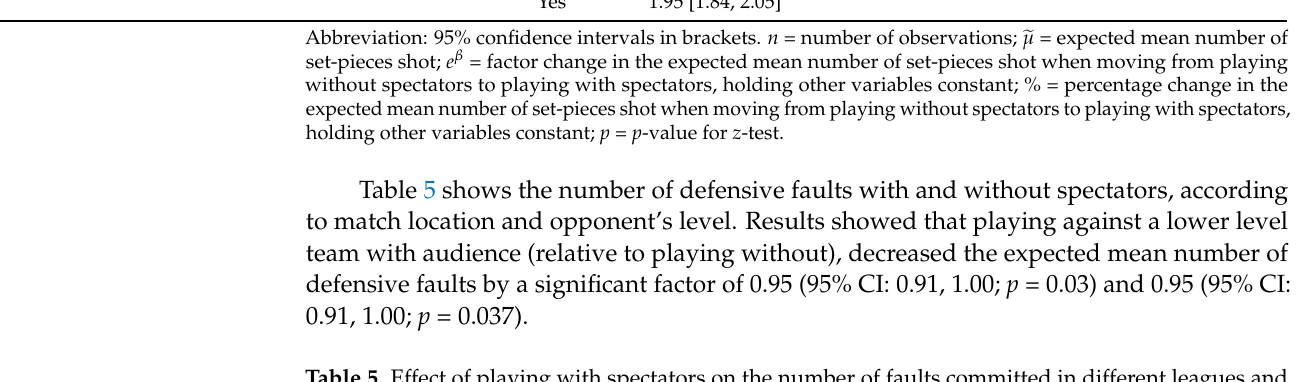
Table 5. Effect of playing with spectators on the number of faults committed in different leagues and competitive